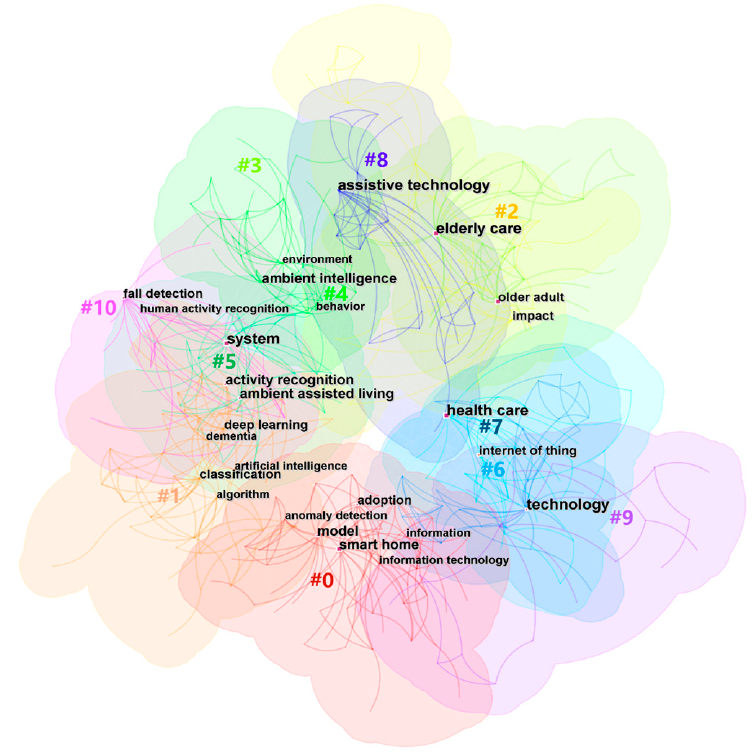
Figure 8. Hot spot cluster of studies from WOS.